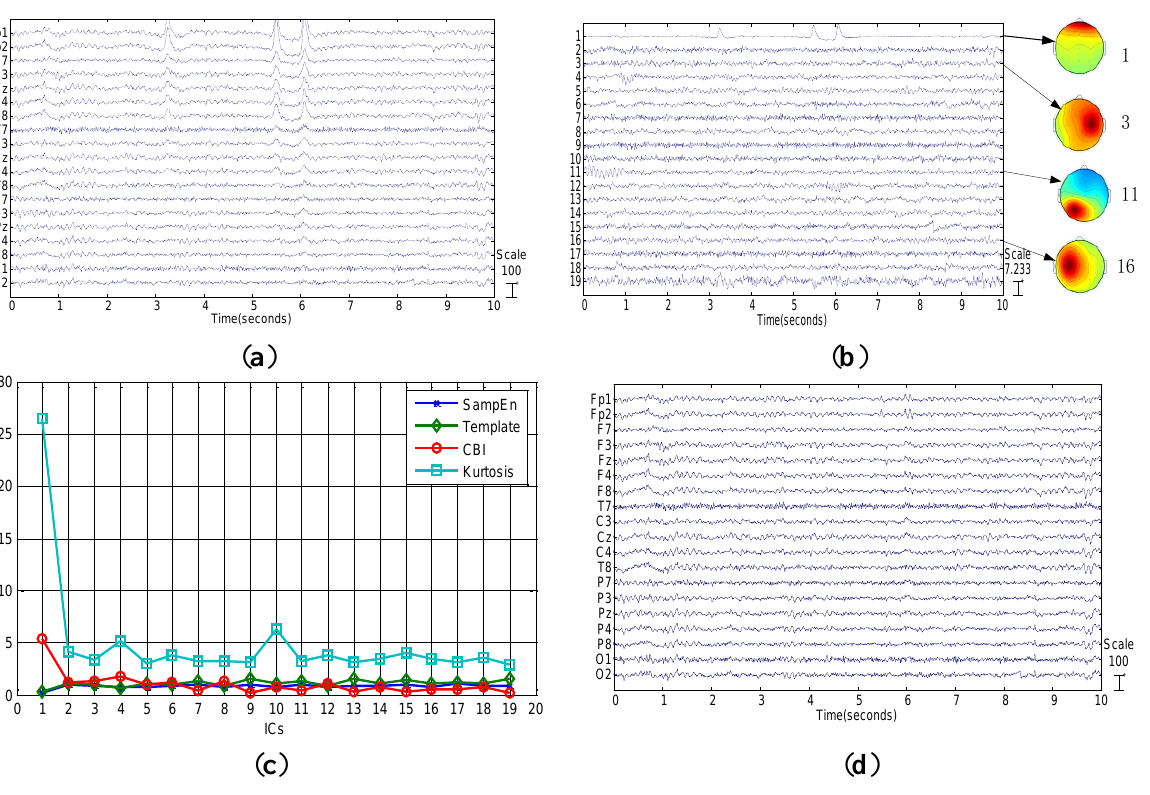
Figure 6. Blinks case. ( a ) Original signals; ( b ) Independent components decomposed by Extended Infomax ICA and power topographies corresponding to some components; ( c ) Values of CBI, sample entropy, Kurtosis and template angle corresponding to all components; ( d ) Reconstructed signals after blink artifact removal by the proposed